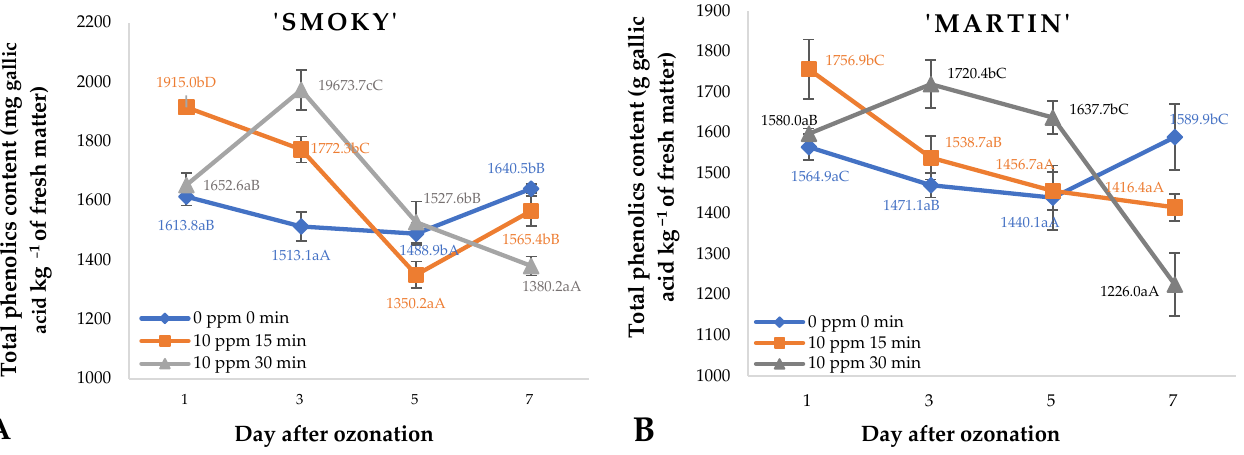
Figure 4. Total polyphenolic content and standard error of the means in saskatoon berries of ‘Smoky’ ( A ) and ‘Martin’ ( B ) cultivars, relative to the dose of ozone ( n = 3). Note: Differences in results between the dose of ozone on the specific days are indicated by different small letters, and differences between assessment days are indicated by different capital letters. Significance level p < 0.05.